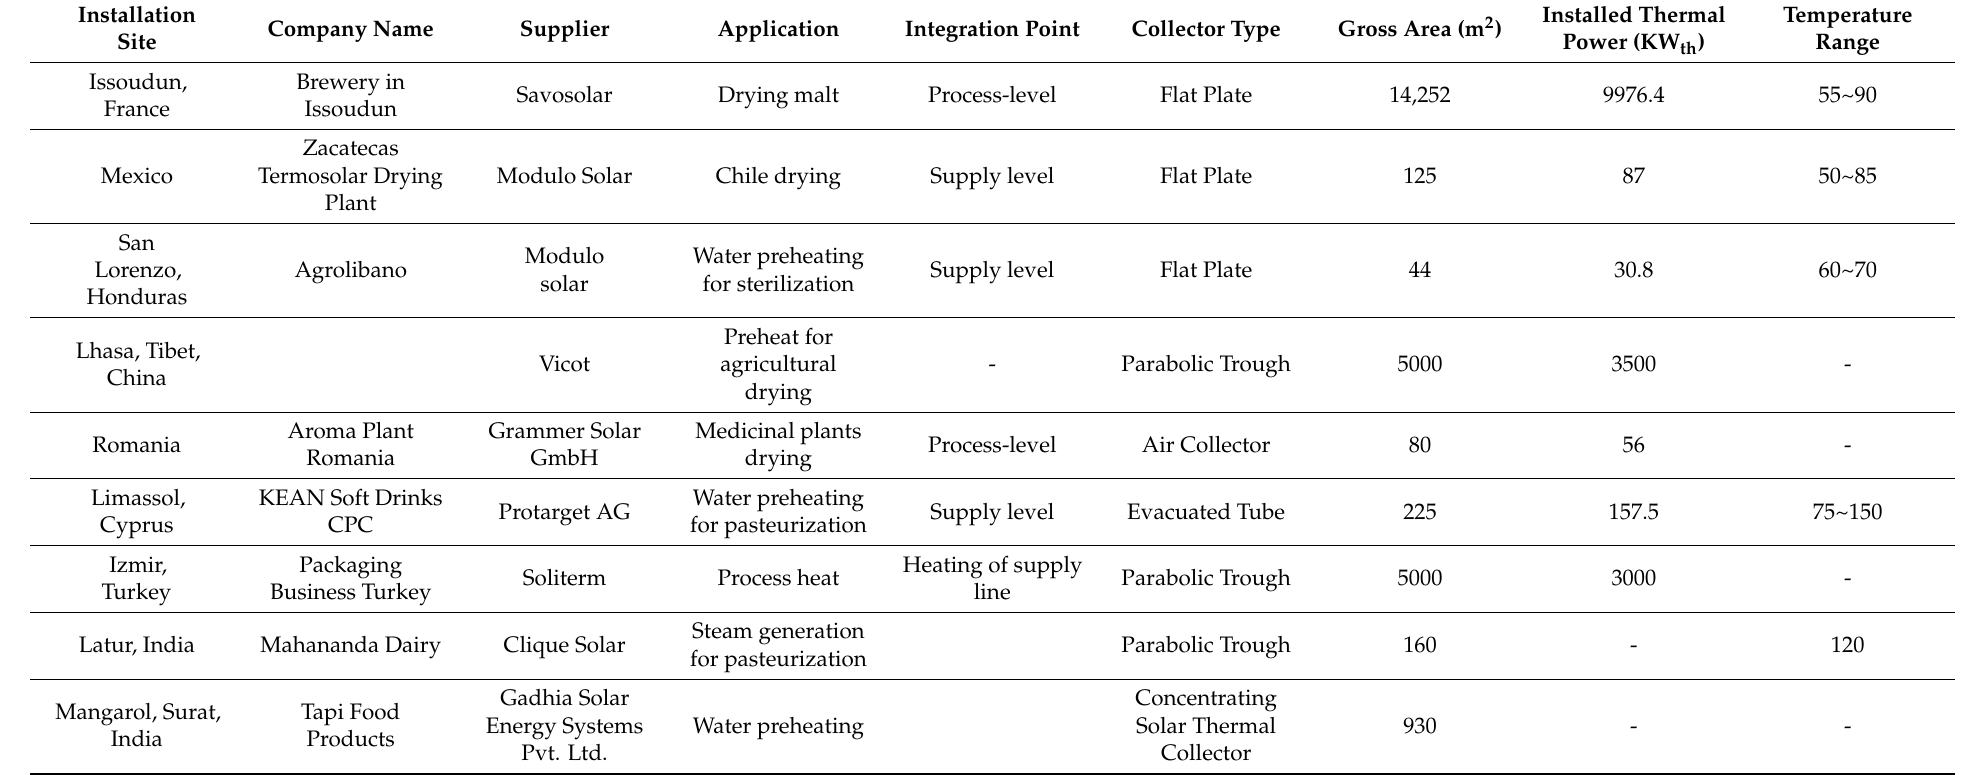
Table 2. Integration scenario in existing SHIP plants for Food Industry